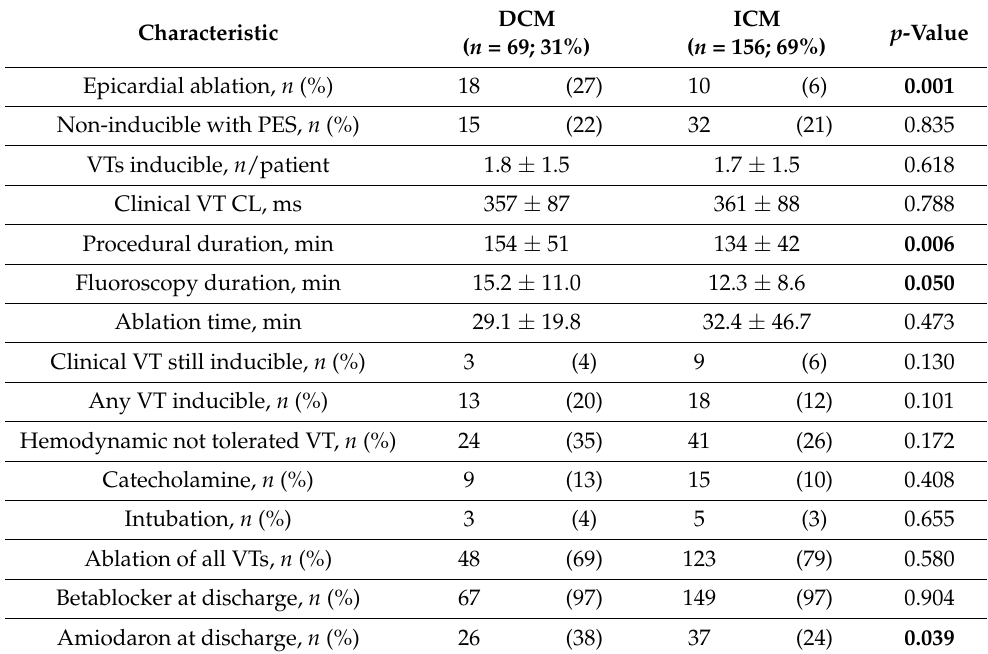
Table 2. Procedural data and intraprocedural